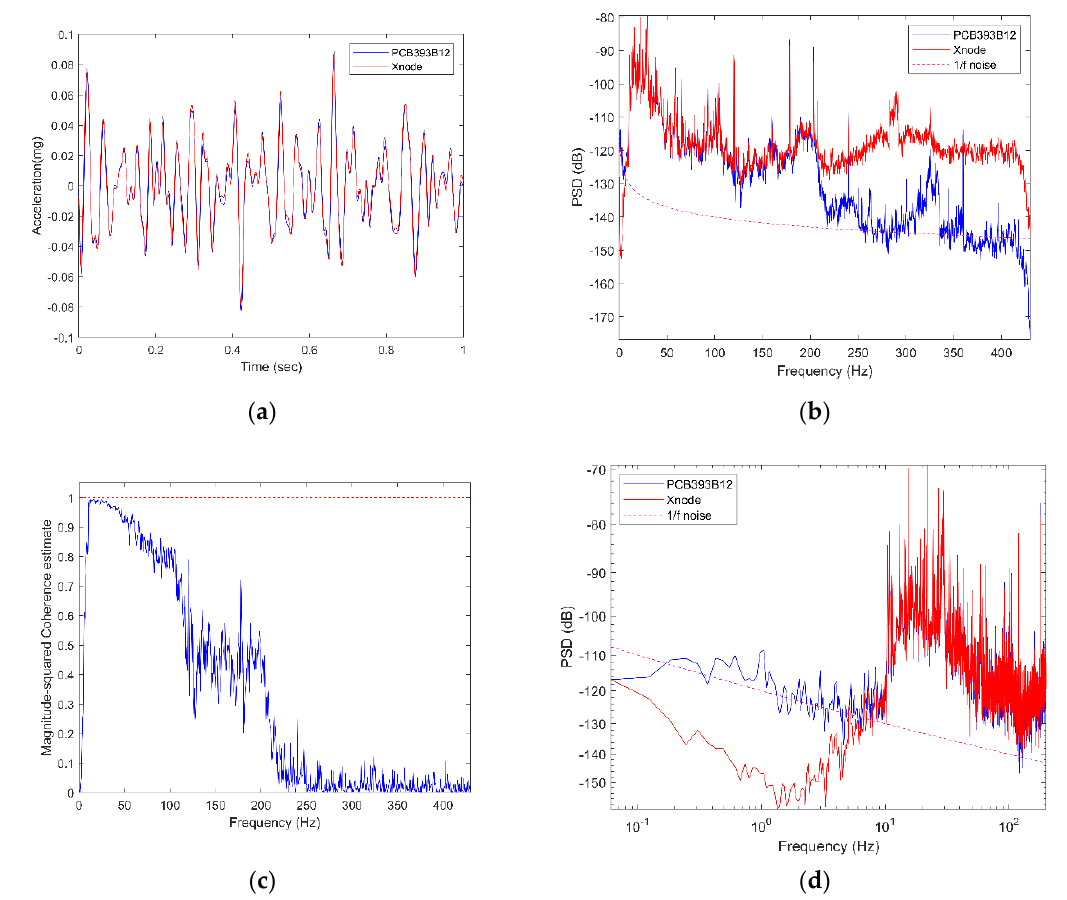
Figure 11. Basement lab ambient vibration test results: ( a ) zoomed-in view of time-history plots for the cut-off frequency of 50 Hz ( b ) Squared-Coherence estimate between the reference and wireless accelerometer ( c ) PSD plot of acceleration records ( d ) PSD comparison in log-log scale.